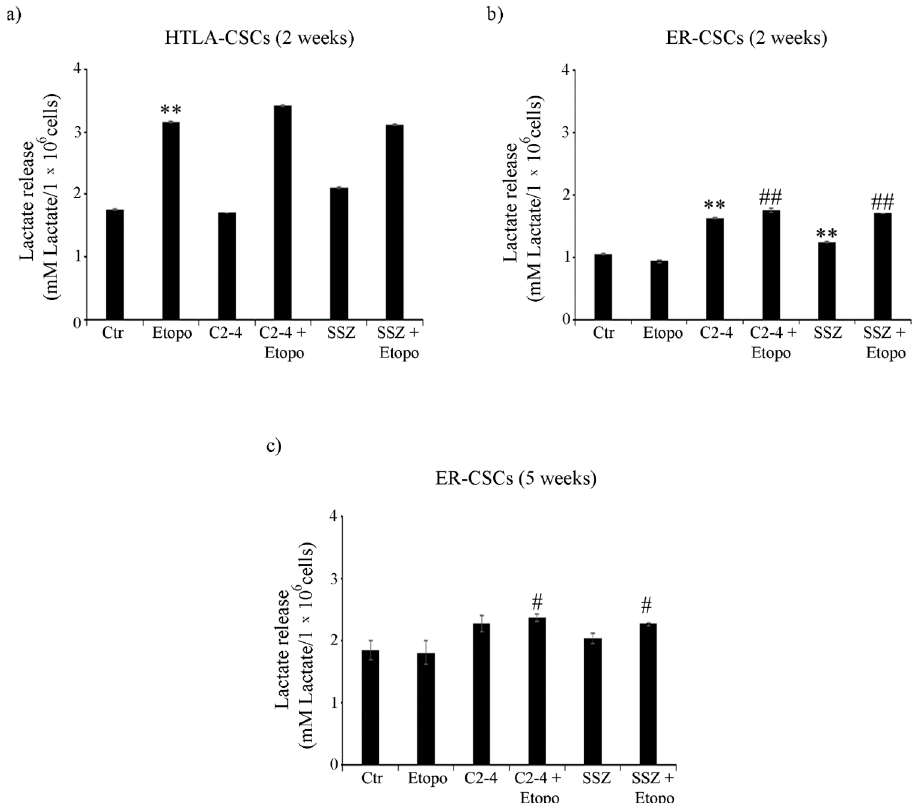
Figure 7. Lactate release in both CSC populations treated for two ( a , b ) or five weeks ( c ). HTLA-CSCs and ER-CSCs were treated three times a week with 0.1 µM C2-4, with 5 µM SSZ or with 1.25 µM Etoposide, administered once a week alone or in combination with C2-4 or SSZ. Results were reported as mM lactate/10 6 cells. Bar graph summarizes quantitative data of means ± S.E.M. of three independent experiments. ** p < 0.01 vs. untreated CSCs (Ctr); # p < 0.05 vs. Etoposide-treated CSCs; ## p < 0.01 vs. Etoposide-treated CSCs.